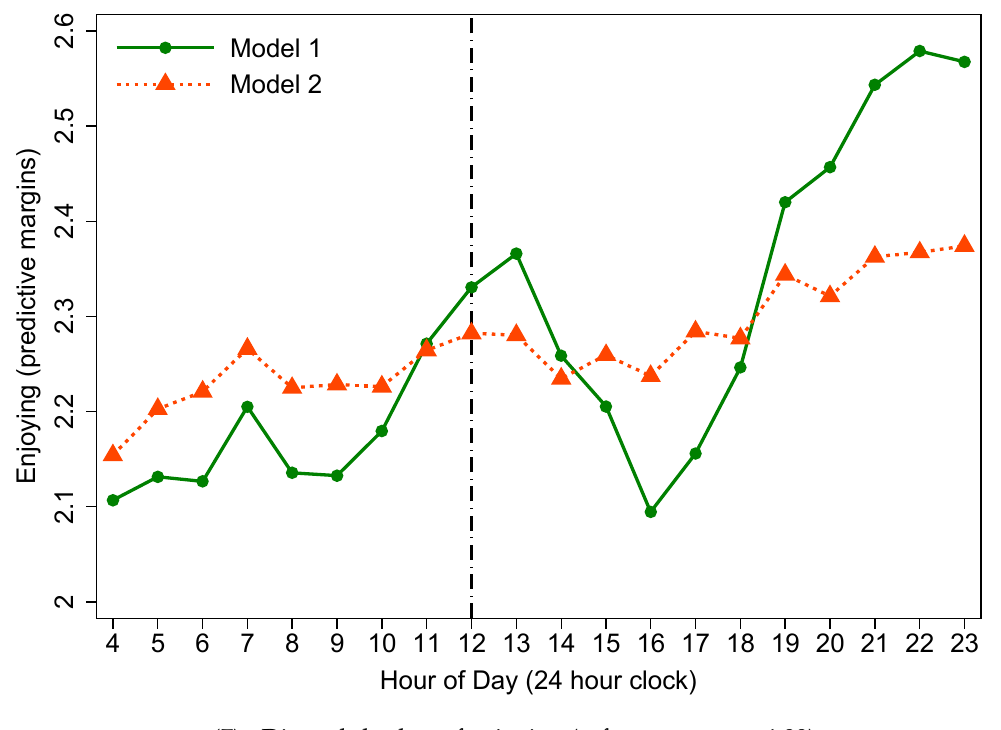
(7) Diurnal rhythm of enjoying (reference group: 4:00). Figure A1. Diurnal rhythms of seven emotions (reference group: 4:00). Figure A1. Diurnal rhythms of seven emotions (reference group: